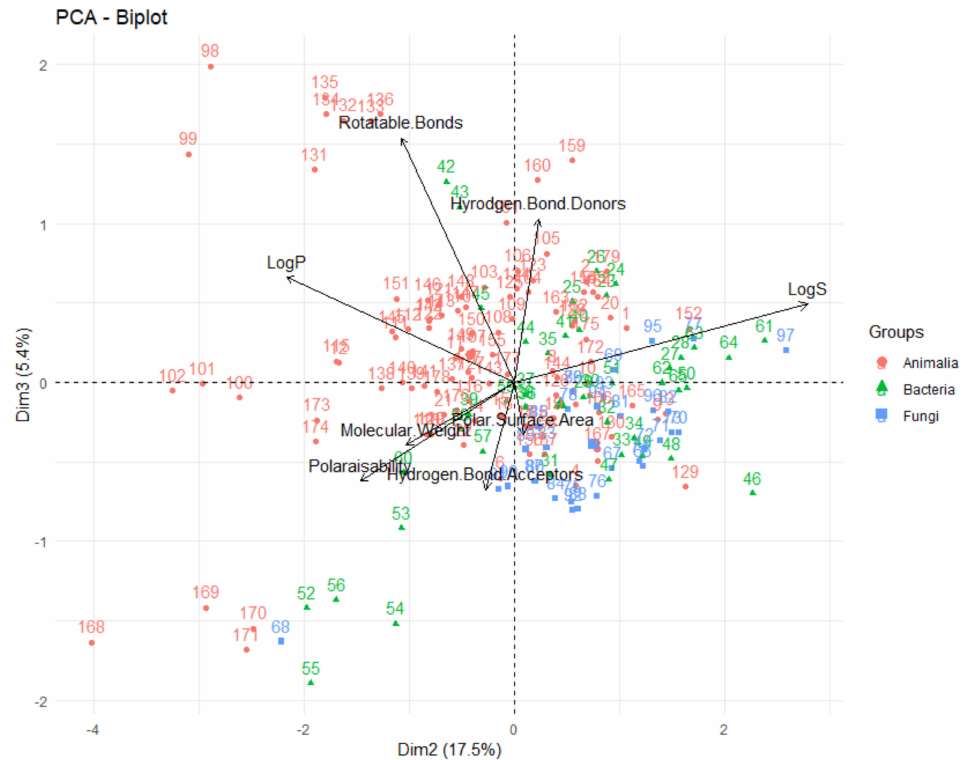
Figure 16. Biplot representing the PCA analysis on the studied compounds and molecular descriptors. The arrows represent molecular descriptors and the direction in which they hold influence. Each point represents a molecule in this study (red = animalia, green = bacteria, blue =